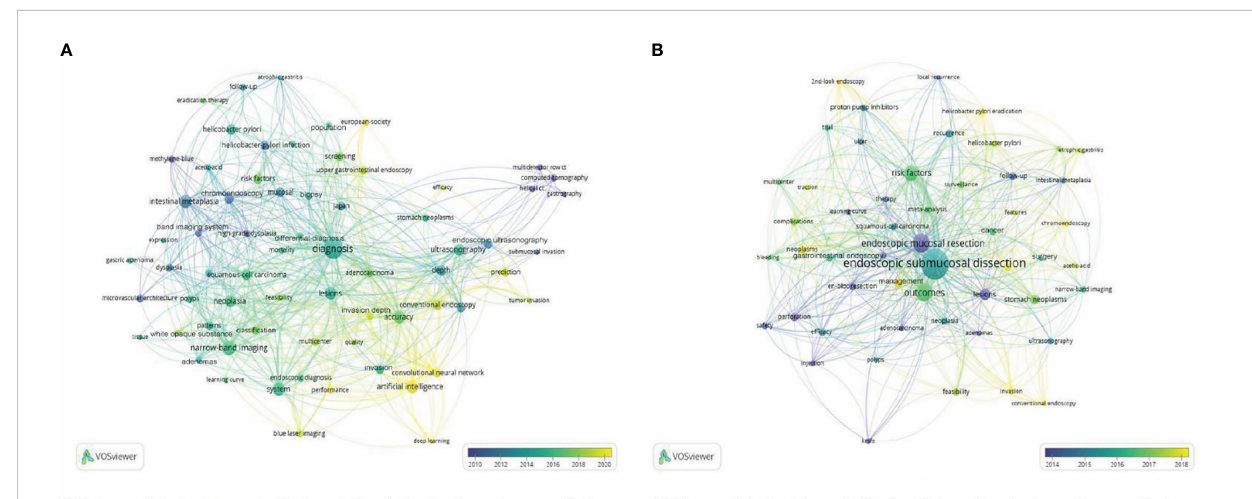
FIGURE 8 (A) Overlay visualization of keywords in topic 1 “ endoscopic diagnosis ” ; (B) Overlay visualization of keywords in topic 2 “ endoscopic therapy ”